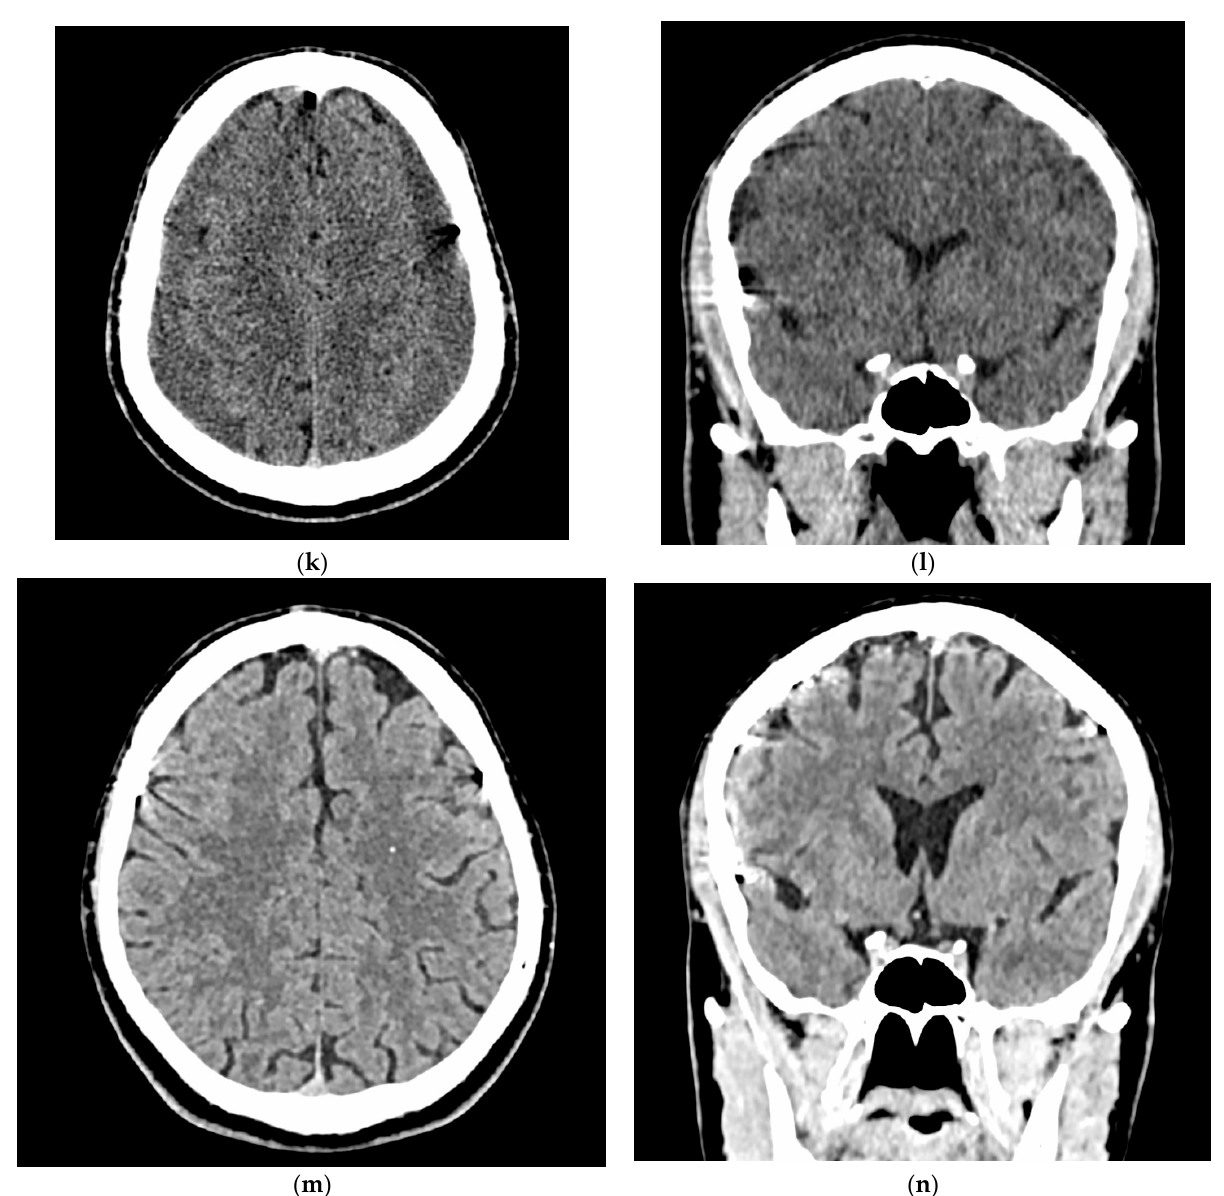
Figure 5. NCCT 30 days after closed head trauma and 1 month before the embolization shows bilateral CSDH (axial ( a ) and coronal ( b )) images, calculated CSDH volumes: Left 68 mL, right 54 mL. The corresponding NCCT 1 month later and 1 day before the MMA embolization shows an increase of the CSDH volumes (axial ( c ) and coronal ( d )) images, calculated CSDH volumes: left 83 mL, right 69 mL. Both MMAs were embolized with Squid. Posterior–anterior ( e ) and lateral ( f ) radiographic images show the radiopaque cast in both MMAs (arrows). An early follow-up NCCT on day 1 after the embolization ruled out any adverse event (axial ( g ) and coronal ( h ) scans). The volumes were calculated as 71 mL on the left and 68 mL on the right. One week after the embolization, the left CSDH was slightly larger than before, while the right CSDH was smaller by a volume of 13 mL (axial ( i ) and coronal ( j ) scans). One month after the embolization, both CSDHs were smaller, with a volume of 42 mL on the left and 47 mL on the right (axial ( k ) and coronal ( l ) scans). The final follow-up NCCT at 6 months demonstrated only minimal remnants of both CSDH (axial ( m ) and coronal ( n ) scans).